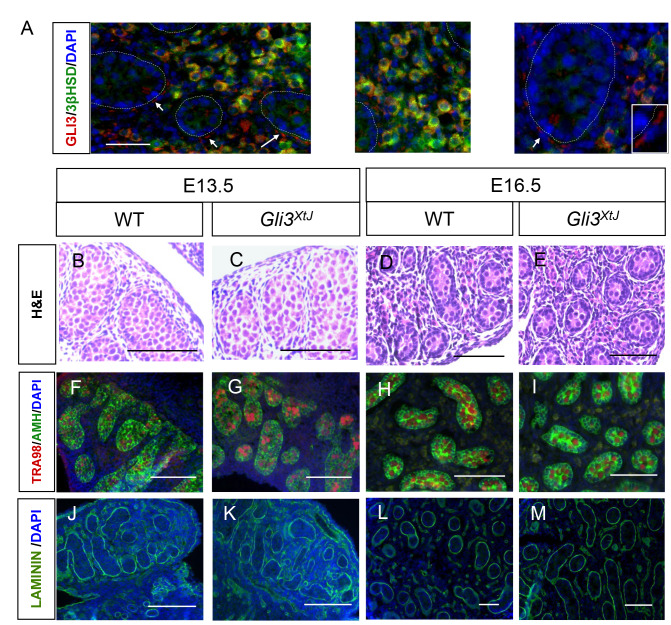
Gli3XtJ mutant embryos have normal testicular morphology.A) Double stain immunohistochemistry was used to detect β-galactosidase (red, marked GLI3) along with 3βHSD (Leydig cell marker, green) in E16.5 testes of Gli3-LacZ embryos. DAPI marks cell nuclei in blue. Yellow denotes co-localization in fetal Leydig cells. Arrows denote peritubular myoid cells; testis cords are outlined by dotted lines. B-M) Representative images of testis sections at E13.5 and E16.5 comparing wild type and Gli3XtJ mutant embryos—H&E staining (B-E), immunostaining for germ cell marker, TRA98 (red) and Sertoli cell marker, AMH (green) (DAPI nuclear counterstain, blue; F-I), and immunostaining for laminin (green) (DAPI nuclear counterstain, blue; J-M) to highlight intact basement membranes.